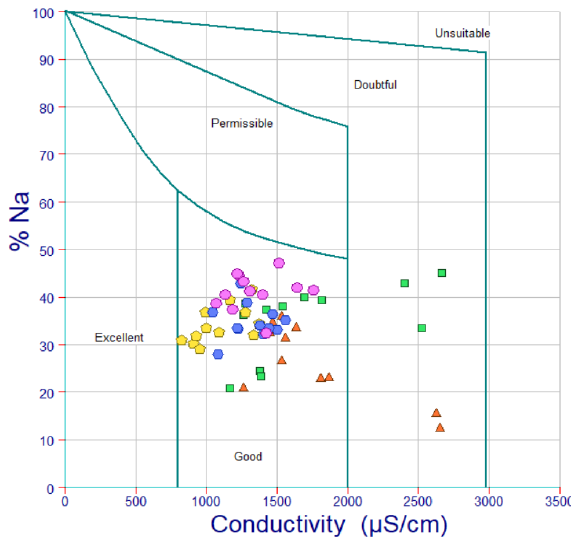
Fig. 4. Classification of irrigation water using Wilcox’s